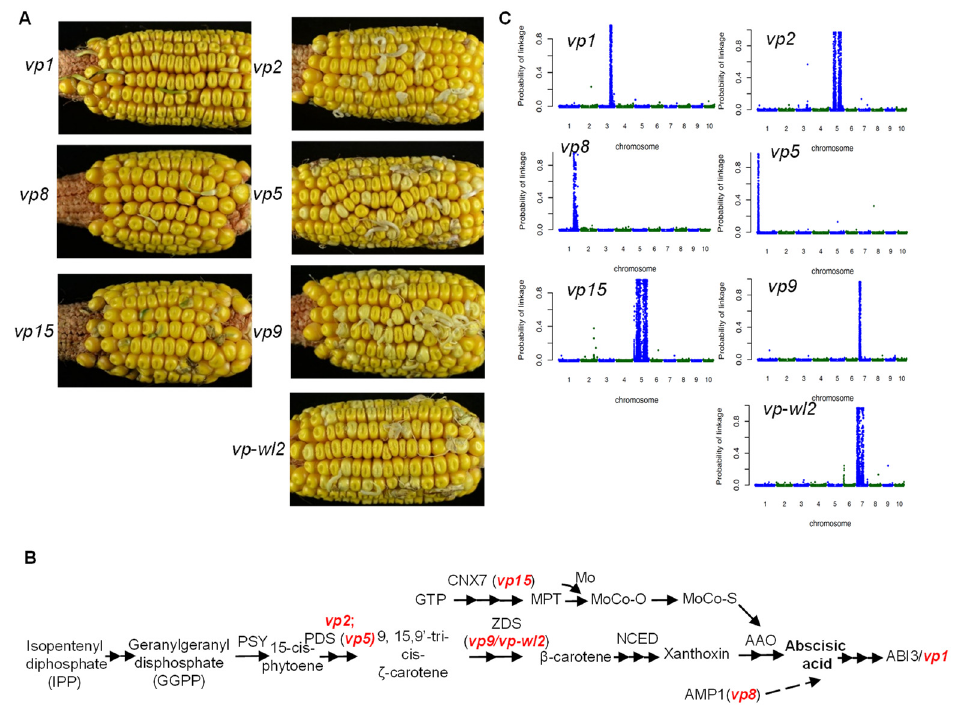
Figure 1. Mapping of each of seven vivipary genes via BSR-Seq. ( A ) Viviparous and normal seeds on heterozygous ears at 60 days after self-pollination of seven viviparous maize mutants vp1 , vp2 , vp5 , vp8 , vp9 , vp-wl2 , and vp15 . ( B ) The ABA biosynthesis pathway in plants. The red font indicates the position of the mutants in the pathway. ( C ) BSR-Seq results for each viviparous mutant. The physical position of each SNP marker was plotted versus the probability of each SNP marker being in complete linkage disequilibrium with the causal gene ( y -axis). The interval length of the x -axis of each plot was determined by corresponding chromosome length. SNP markers on adjacent chromosomes are distinguished by blue and green dots.